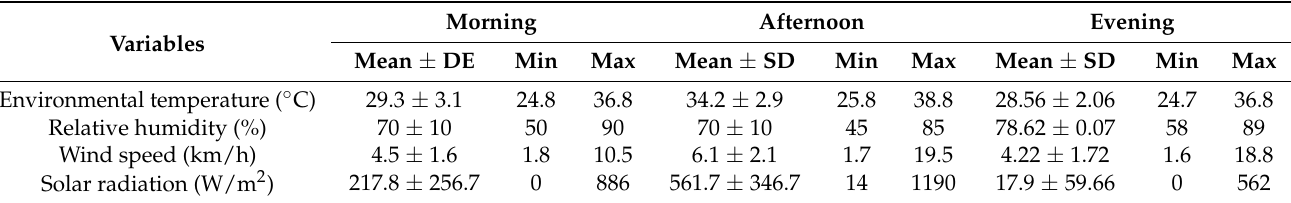
Table 2. Descriptive statistics for climatic variables (mean ± standard deviation (minimum and